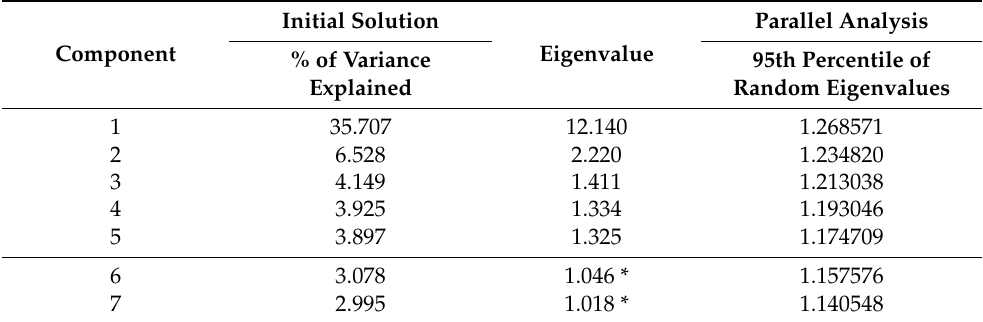
Table 1. Extracted principal components with Eigenvalues, percentage of explained variance, and parallel analysis criterion—experiencing cyber-violence subscale. Initial Solution Component